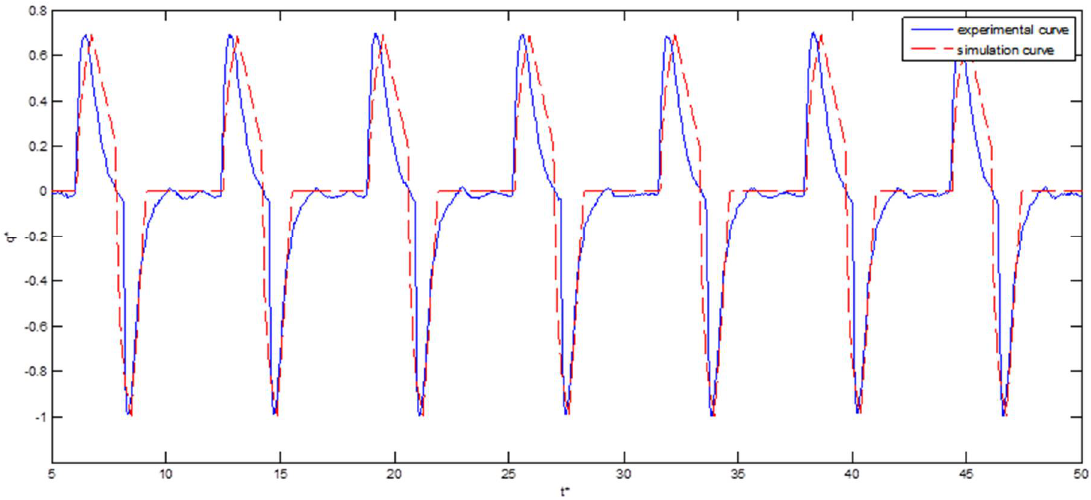
Figure 5. Curve of dimensionless flow in one lung.